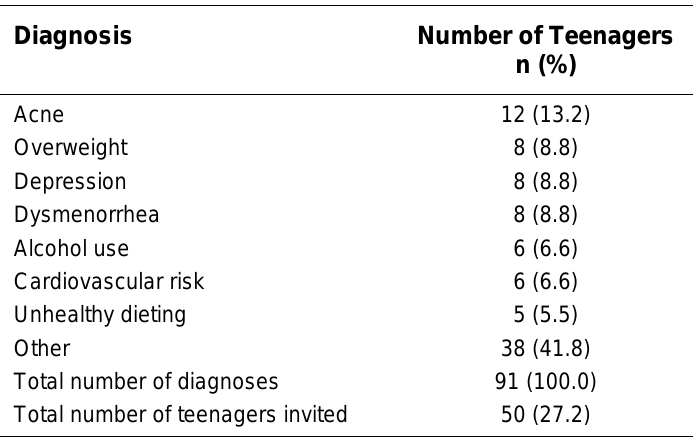
Reasons for Follow-Up